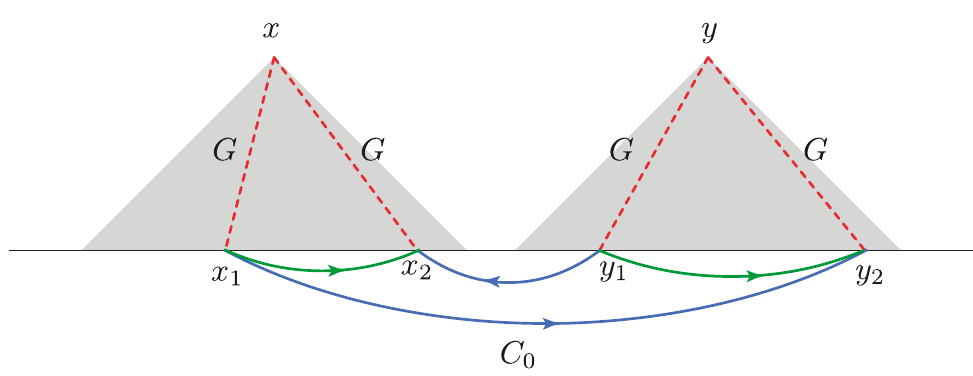
Figure 8 . Diagrammatic representation of the convolution formulas (C.22) and (C.23) for the derivation of dynamics of correlations at the free fermion point. The dashed red lines denote the propagators, the blue and green lines denote the Klein factor contractions corresponding to the initial fermionic